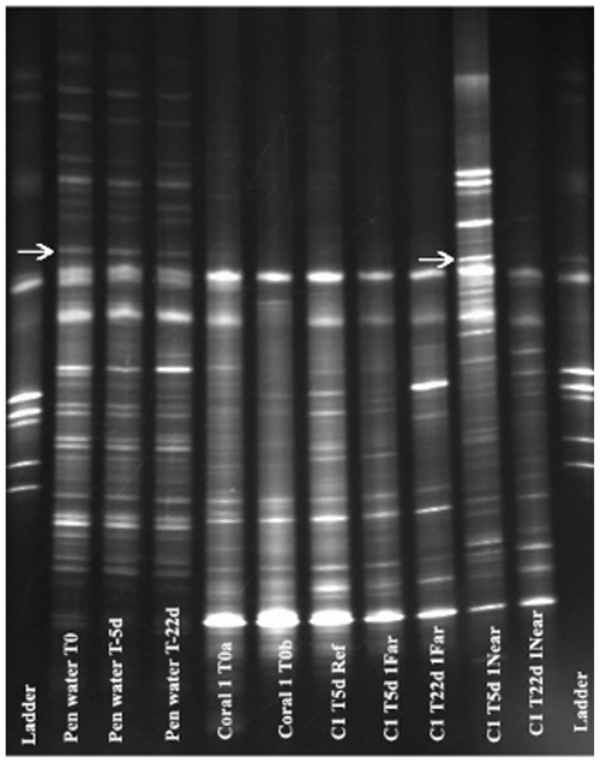
Figure 3. DGGE image showing Roseobacter band ( . 97% sequence similarity) at all time points in the Fish Pen water, but only T-5 days at site Near-1 for coral 1.